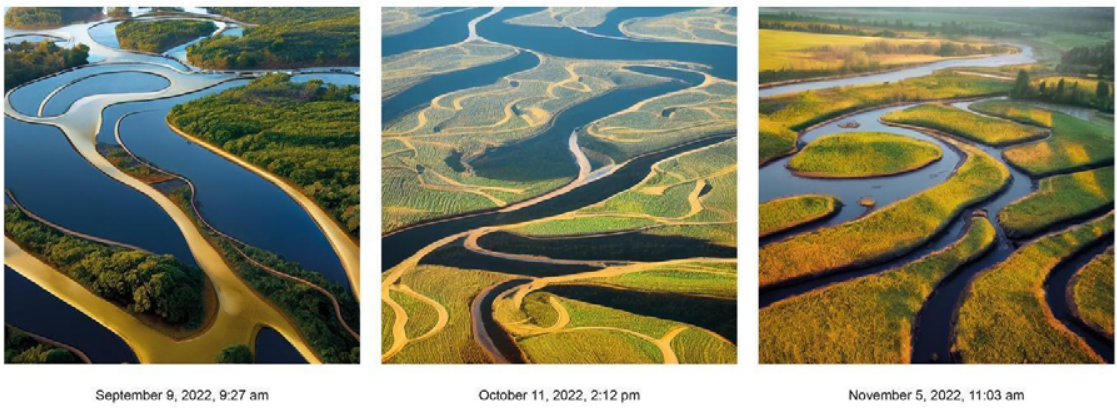
FIG. 9 Three examples of the Midjourney’s response to same prompt (“/imagine: a meandering river with branches in the landscape, meanders, morning light, bird-eye view, ultra realistic, detailed, 8k --upbeta --testp”), tested about a month apart. Source: Gianni Lobosco, through Midjourney’s artificial